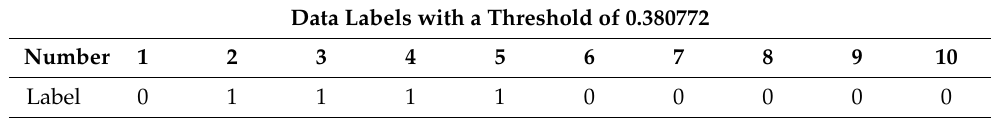
Table 6. Calculation